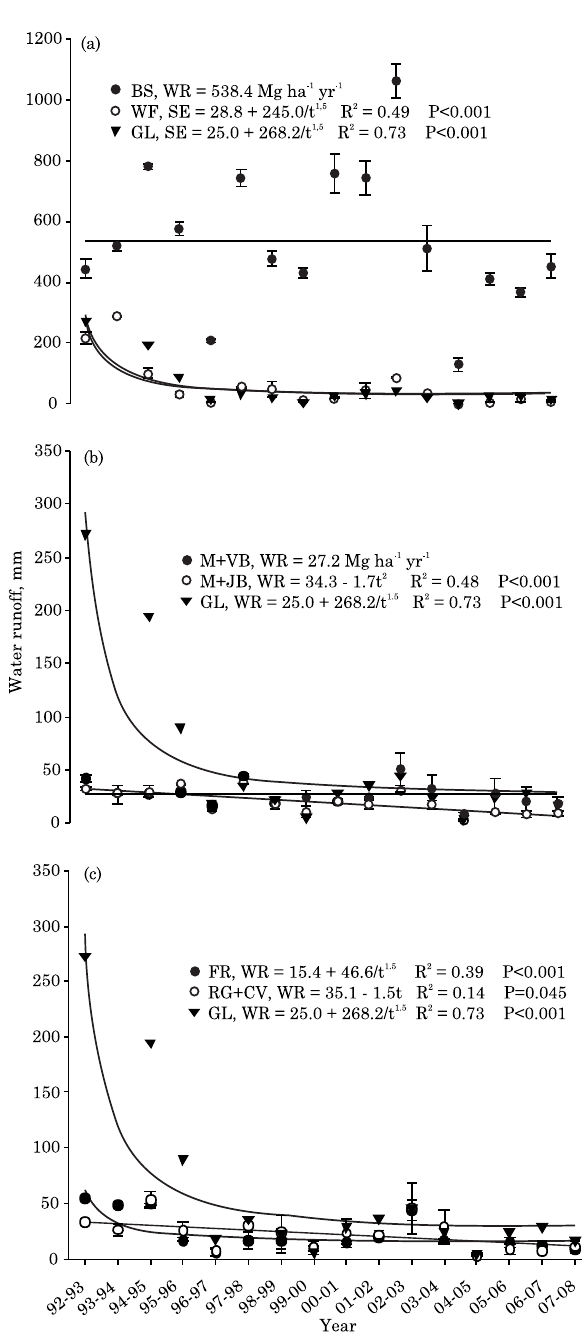
Figure 2. Water runoff from BS, WF and GL (a) M+VB, M+JB and GL (b) and FR, RG+CV and GL (c) treatments as a function of time (years) in a long-term experiment in Santa Maria, RS, Brazil. Vertical bars represents the mean standard error (n=2). BS: bare soil; WF: winter fallow; M+VB: summer consortium maize - velvet bean; M+JB: intercrop of Maize and Jack Bean; FR: Forage Radish; RG+CV: winter consortium ryegrass - common vetch; GL: grassland. Water runoff from GL was repeated in all graphs for better comparison of the